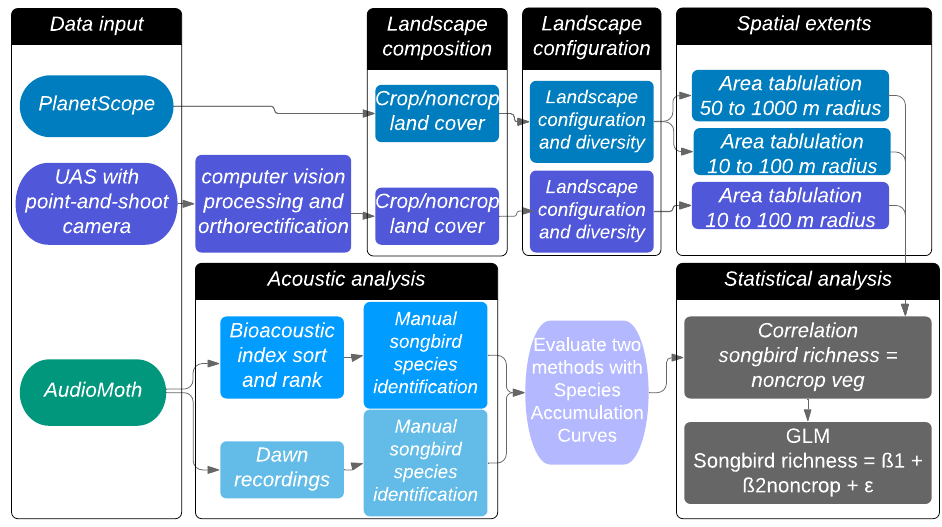
Figure 2. A flowchart representing the analysis steps.